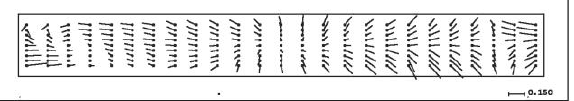
Figure 13. Correction grid forward camera, average of 4